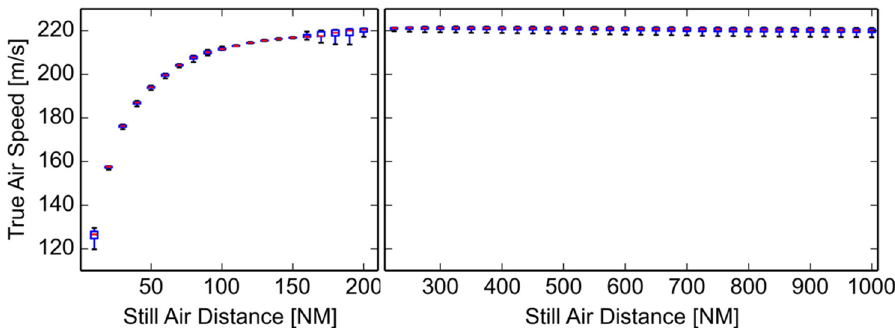
Figure 6. Variation in true air speed during the climb phase ( left ) and during the cruise phase ( right ). Means are marked in red while upper and lower quantiles (indicating the 75% quantiles) and whiskers (for minimum and maximum values) are shown in blue.